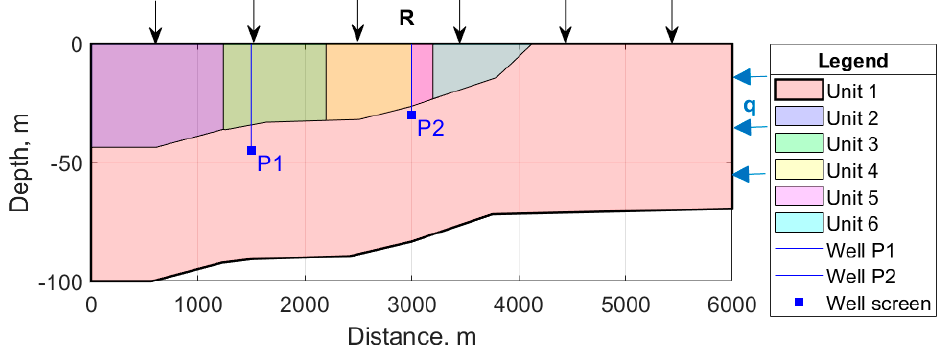
Figure 10. View of the vertical cross-section highlighted in Figure 9 composed from six aquifer units. The unconfined aquifer is subject to mountain-block recharge from the right (q), infiltrating recharge from the top (R), and seawater intrusion from the left side.